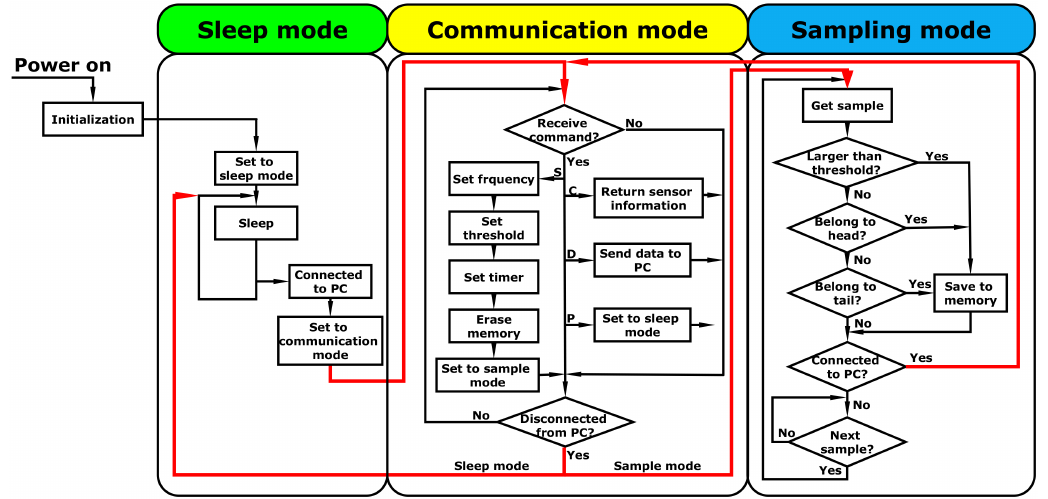
Figure 5. Flowchart of the sensor program. “S”, configure sensor and set sensor to sampling mode; “C”, request sensor information; “D”, upload sensor data to the PC; “P”, set sensor to sleep mode. These letters indicate different types of